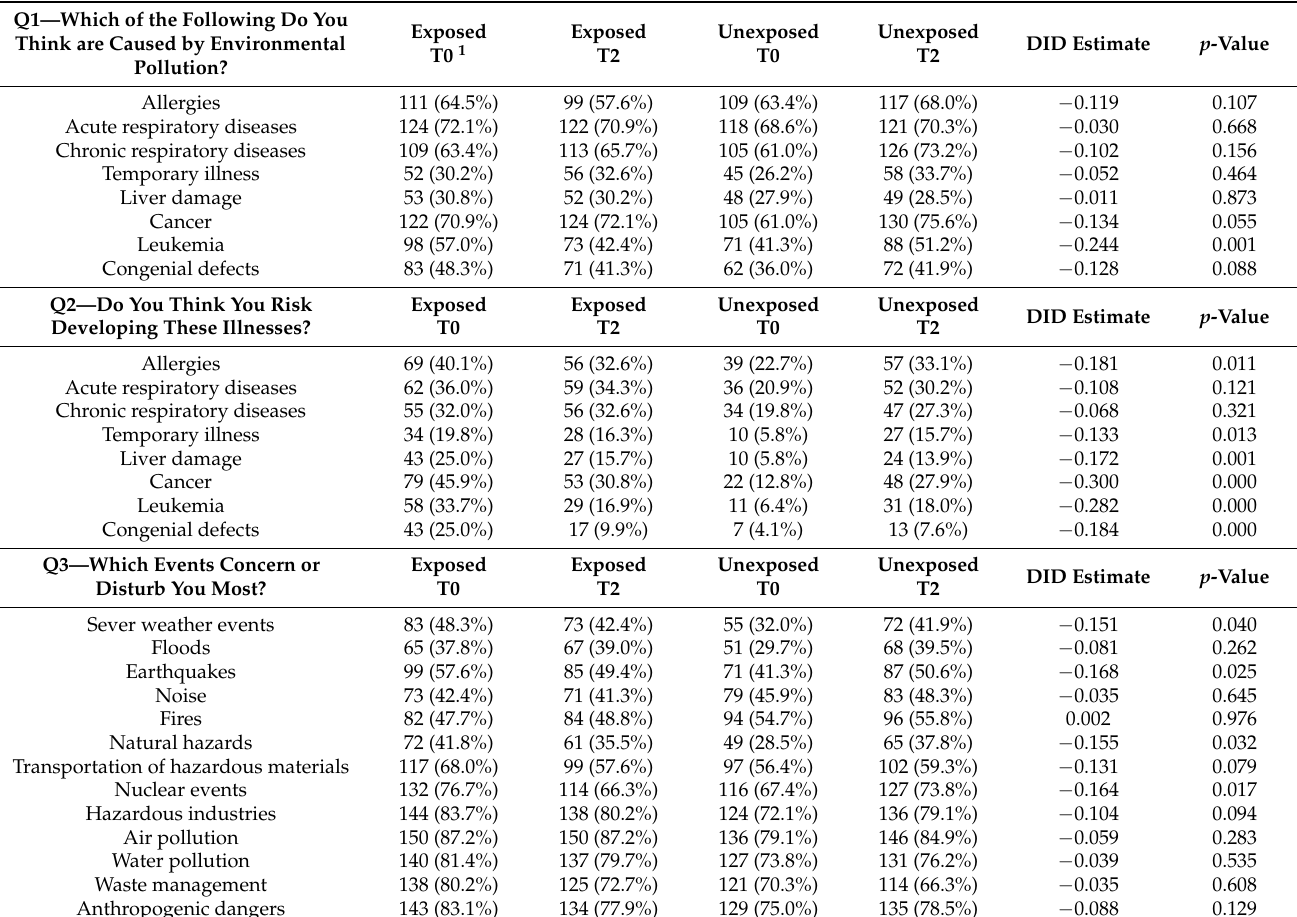
Table 2. Difference-in-differences (DID) results controlled for educational level. Absolute values and percentage of wor- ried people are reported for each item of the questionnaire.